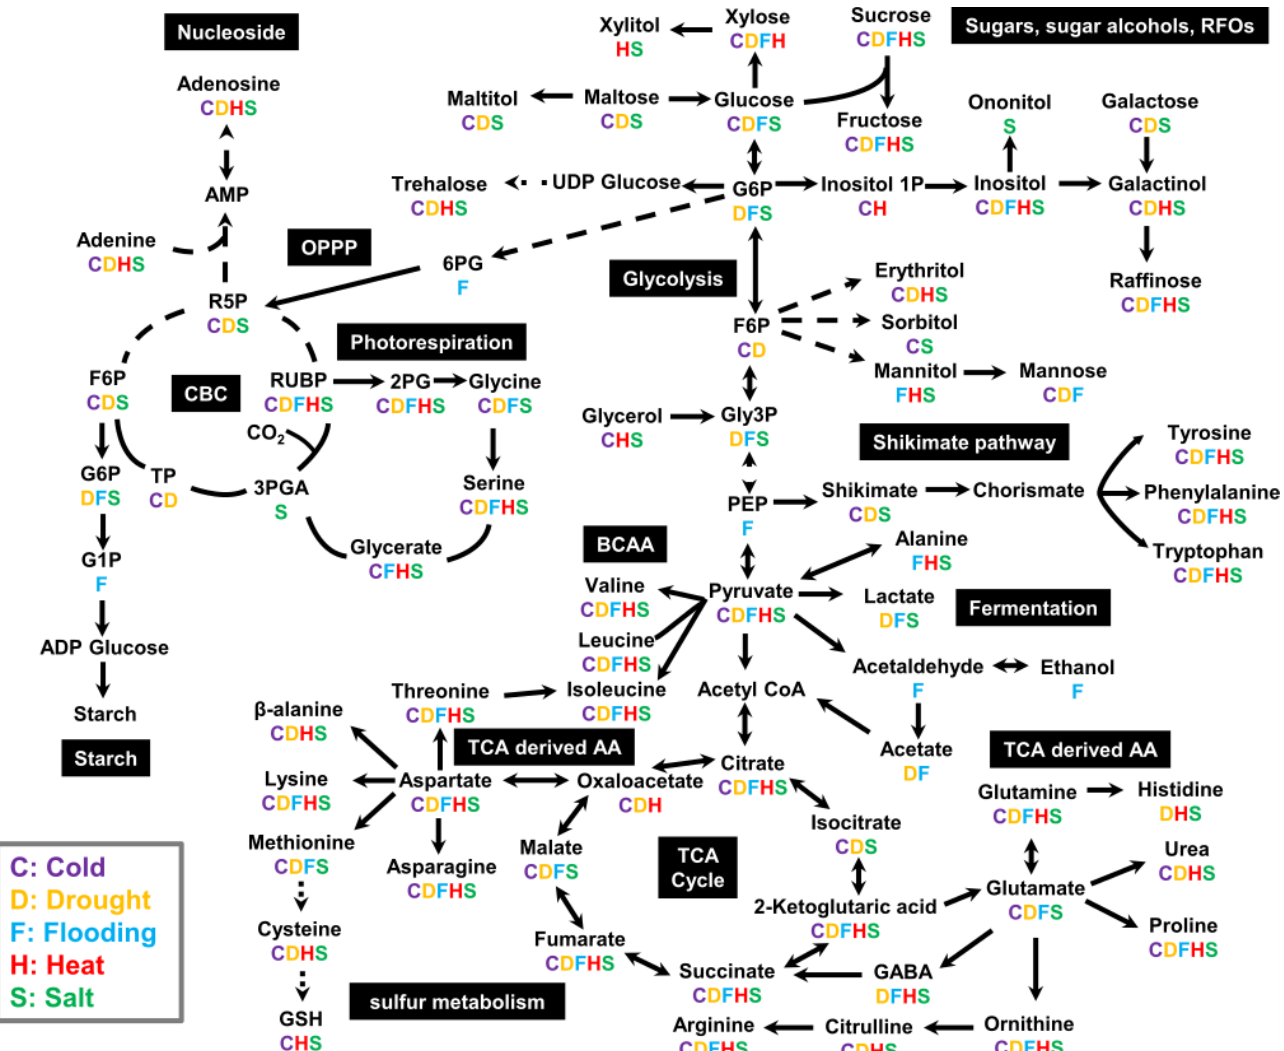
Table 1). Among the summarized metabolites, 52 were affected by cold stresses, 55 by drought, 46 by flooding, 42 by heat, and 58 by salinity. Some stress-related metabolites showed common responses to multiple abiotic stresses, and some metabolites only re- sponded to specific stress. Interestingly, 23 metabolites showed common stress responses to all stresses reviewed in this study, including cold, heat, drought, flooding, and salinity.